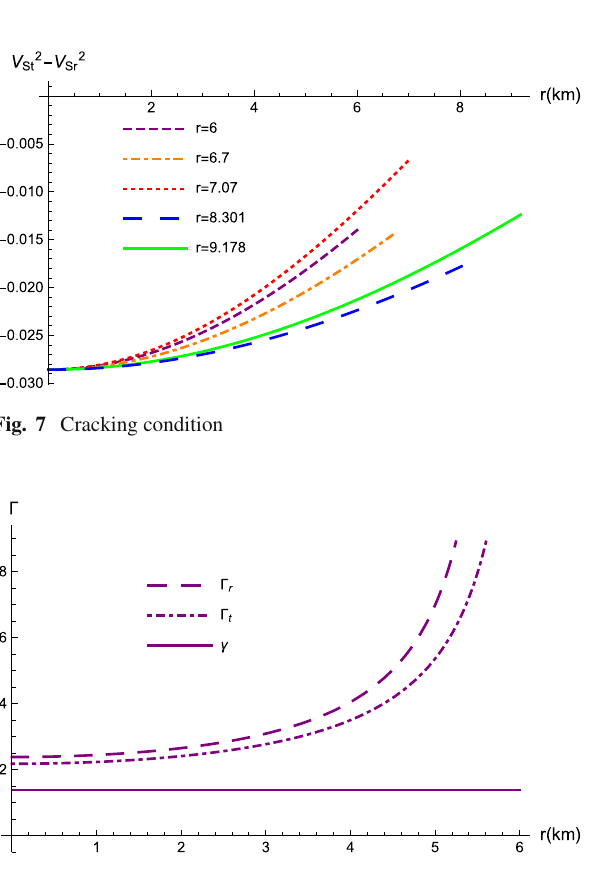
Fig. 9 Adiabatic Index for Her X-1